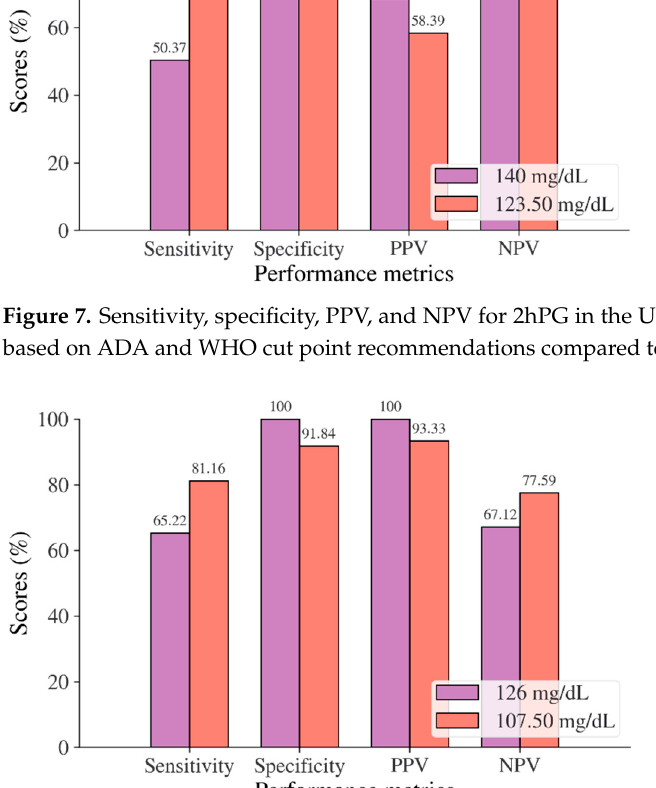
Figure 8. Sensitivity, specificity, PPV, and NPV for FBS in the Trinidadian adult population based on ADA and WHO cut point recommendations compared to the optimal cut point.